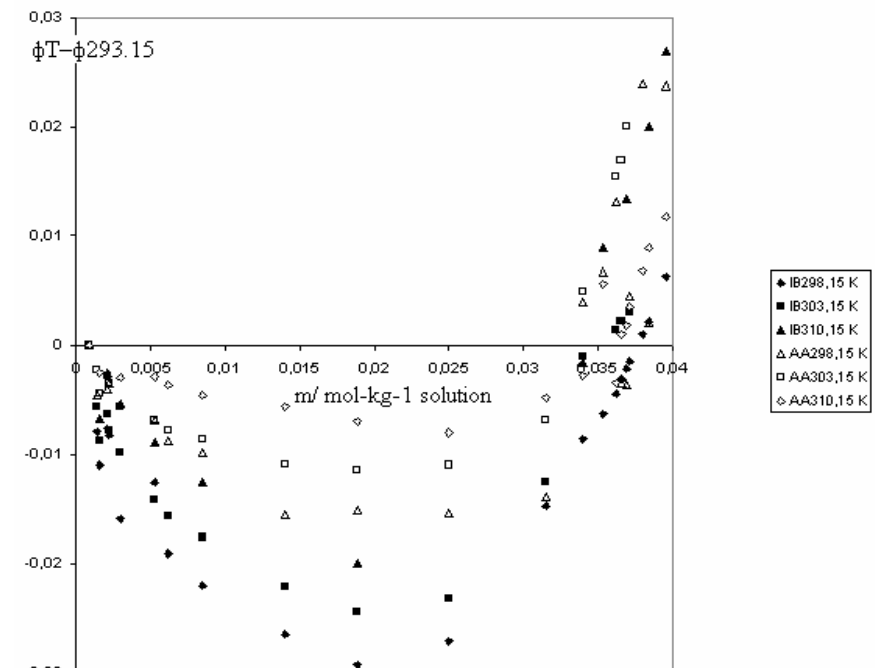
vs . Na-AA and Na-IB concentrations at and ф – ф 293.15K T 293.15